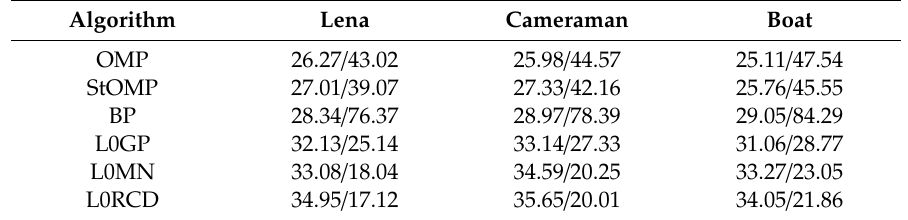
Figure 14. Recovery effect of the six methods on the Boat image. ( a ) original image; ( b ) noisy image; ( c ) OMP; ( d ) StOMP; ( e ) BP; ( f ) L0GP; ( g ) L0MN; ( h ) L0RCD. Table 2. The quantitative results (signal to noise ratio (SNR)/Time consumption(s)) of the six algorithms. Algorithm